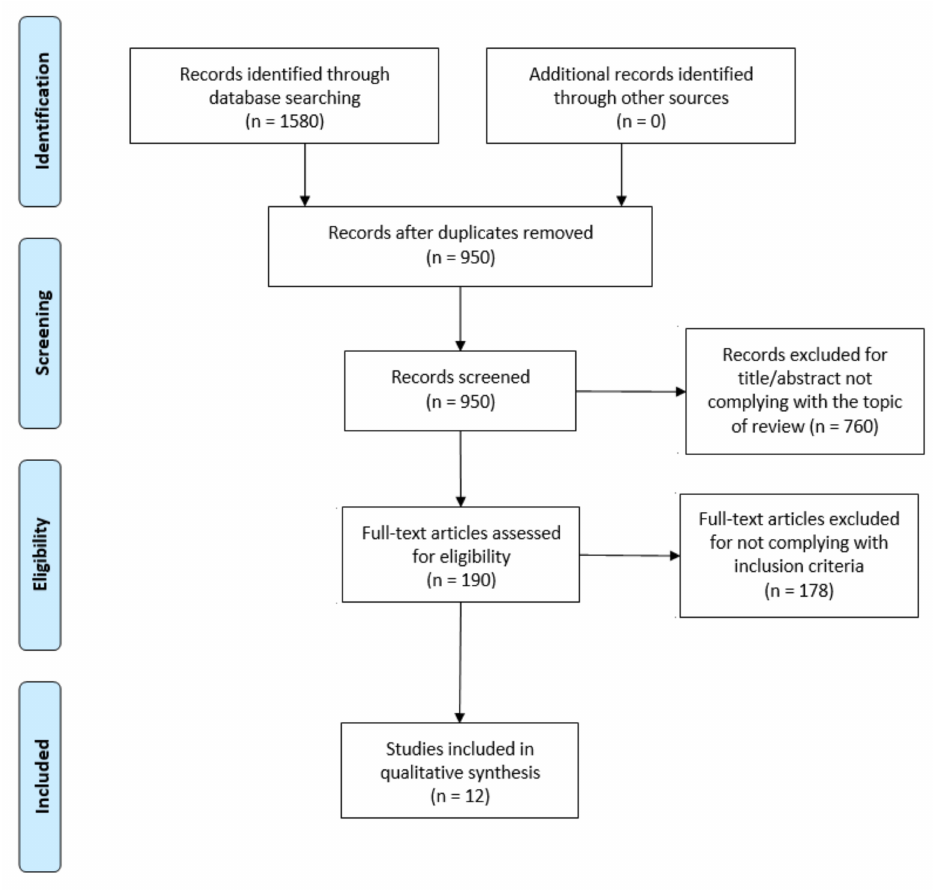
Figure 1. PRISMA flow diagram adapted with permission from The PRISMA group,